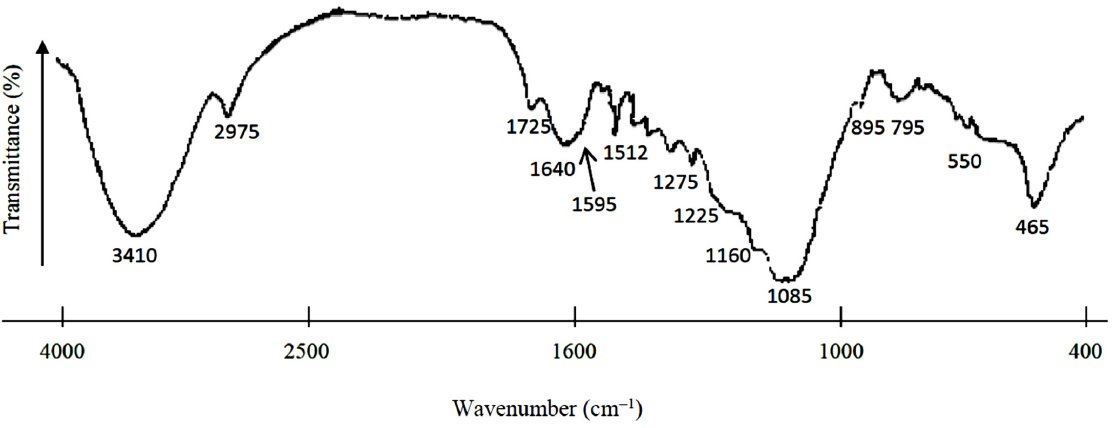
Figure 1. IR spectrum of rice husk.